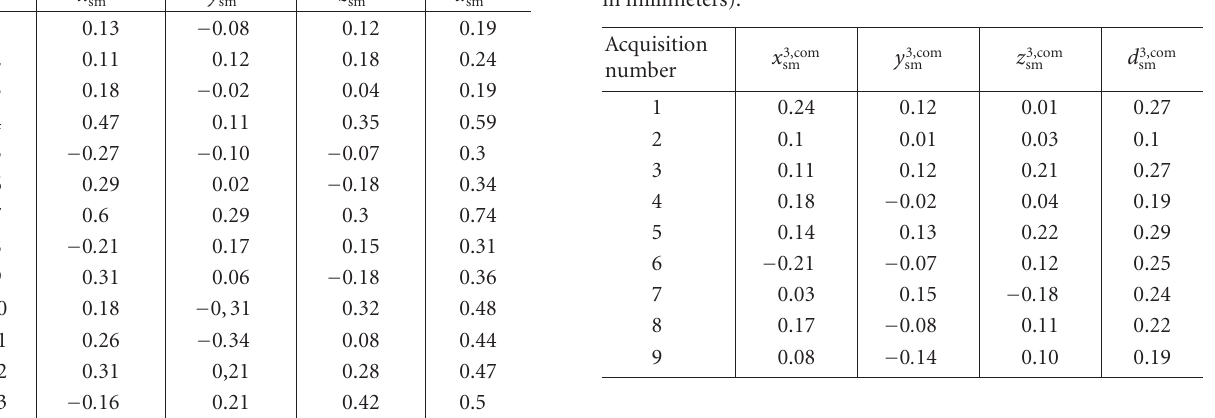
Table 3: Ball 3 positioning results for di ff erent acquisitions and 3D is the distance between the ball with coor- sensor viewpoints. d 3,com sm , y 3,com , z 3,com ) and the isocentre (All values are given dinates ( x 3,com sm sm sm in